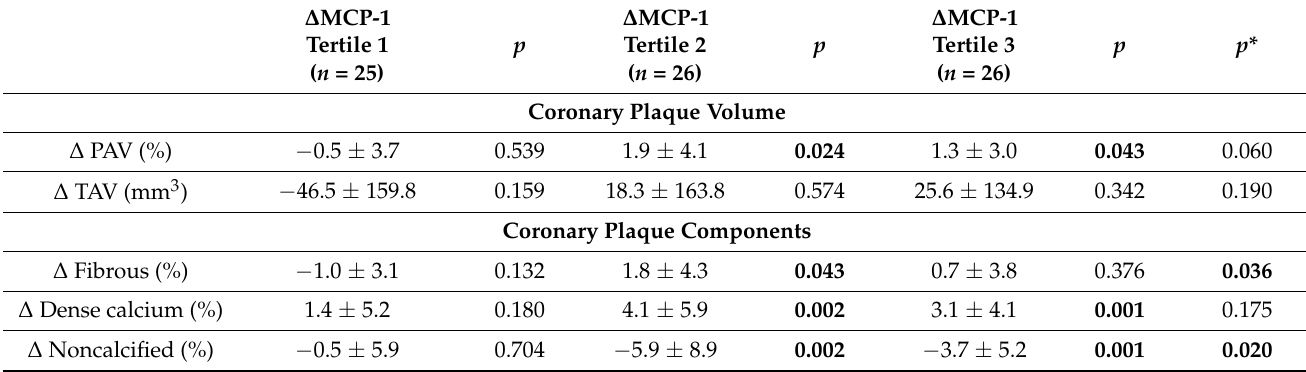
Table 7. Changes ( ∆ ) in the volume and composition of the atherosclerotic plaque within tertiles of changes in MCP-1 concentration in the entire study group ( n = 77). p -values were obtained using paired sample t -test comparing baseline and follow-up values. p * values were obtained using one-way ANOVA comparing intergroup differences. Statistically significant p -values are marked in